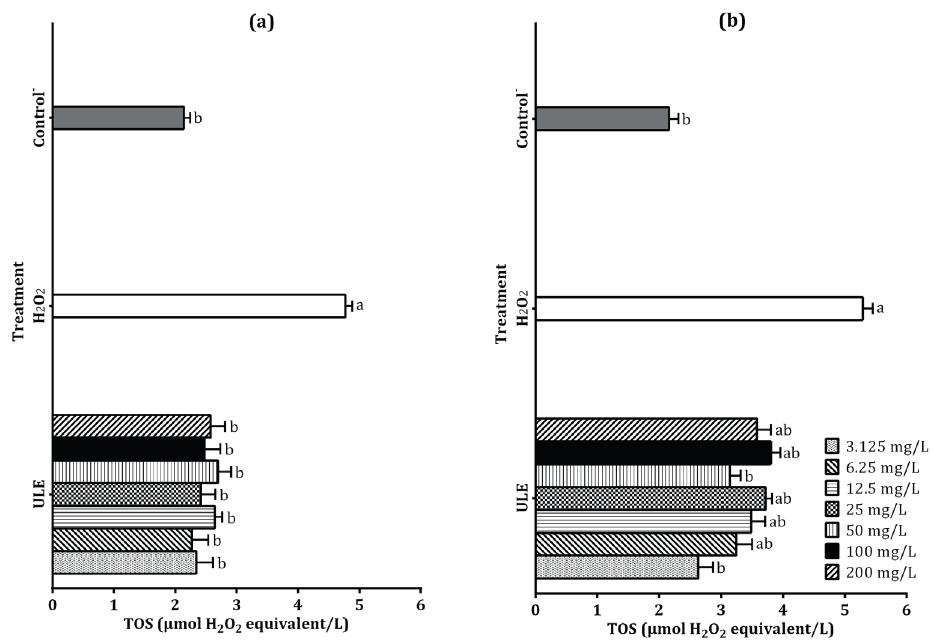
Figure 5 - TOS levels in the cells in the presence of ULE (a) for PMGN cells (b) for U87MG cells. Each value is expressed as mean ± standard deviation ( n = 3). Values followed by different small letters differ significantly at p <